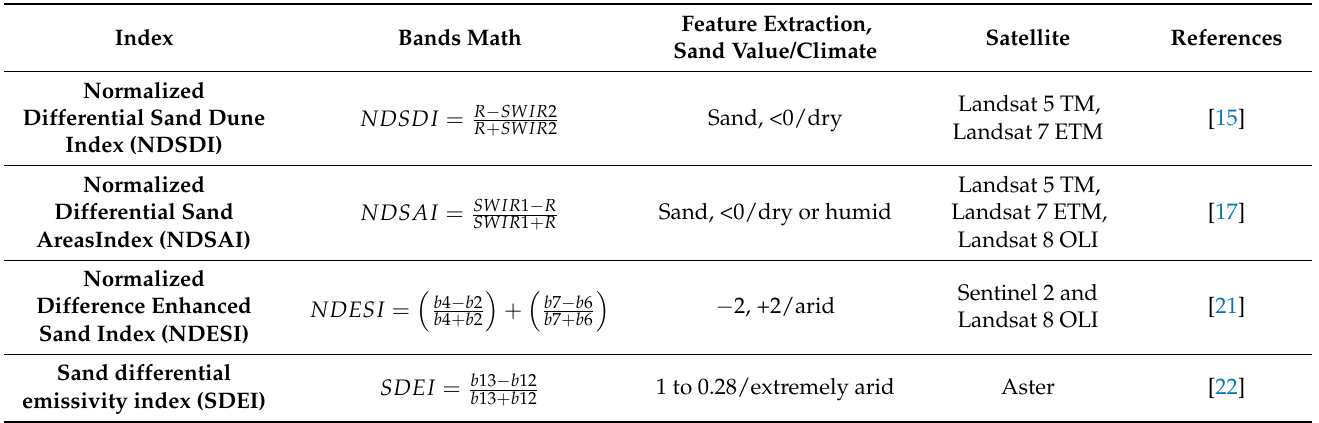
Table 1. Indices used for mapping bare sand